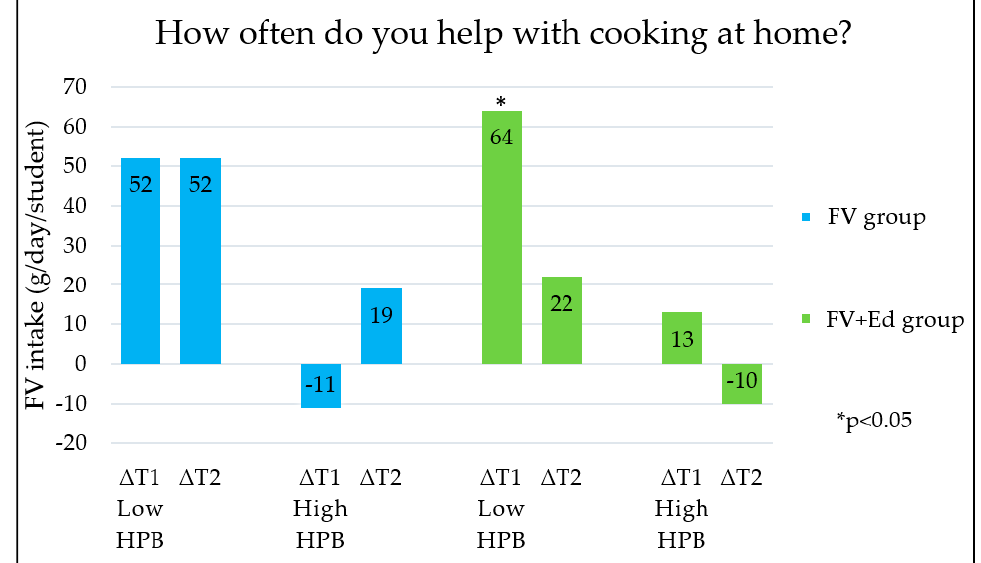
Figure 4. Differences in children’s FV intake, stratified by caregivers’ HPB in FV- and FV + Ed group, compared to the control group—Cooking together. HPB = caregivers’ health promotion behaviour, ∆ T1 = Difference between T0 and T1, ∆ T2 = Difference between T0 and T2.